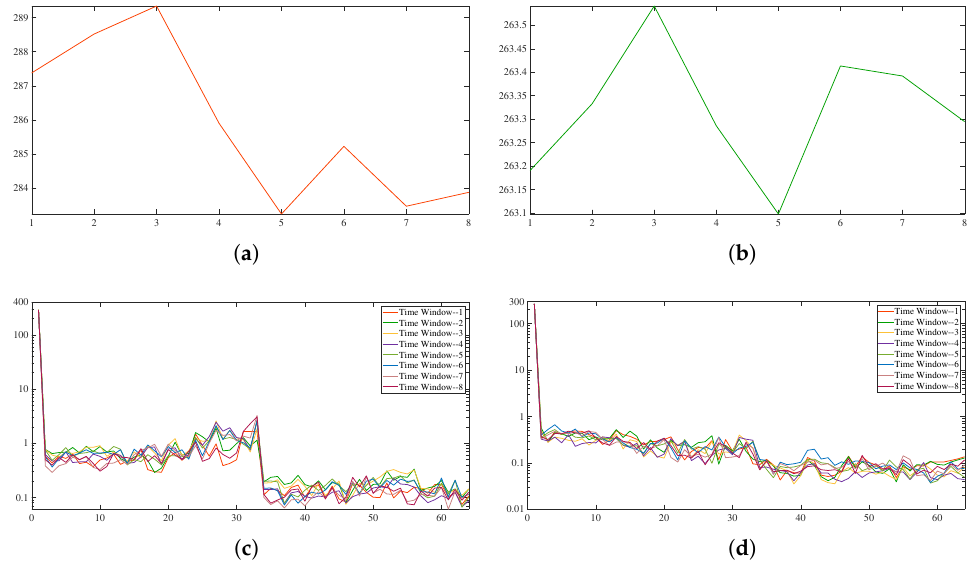
Figure 7. Comparison of wavelet scattering characteristics of cracked eggs and intact eggs. ( a ) The 0th scattering output of Figure 3e of cracked egg sample. ( b ) The 0th scattering output of Figure 3f of intact egg sample. ( c ) Scattering coefficients for 8 time windows of Figure 3e of cracked egg sample. ( d ) Scattering coefficients for 8 time windows of Figure 3f of intact egg